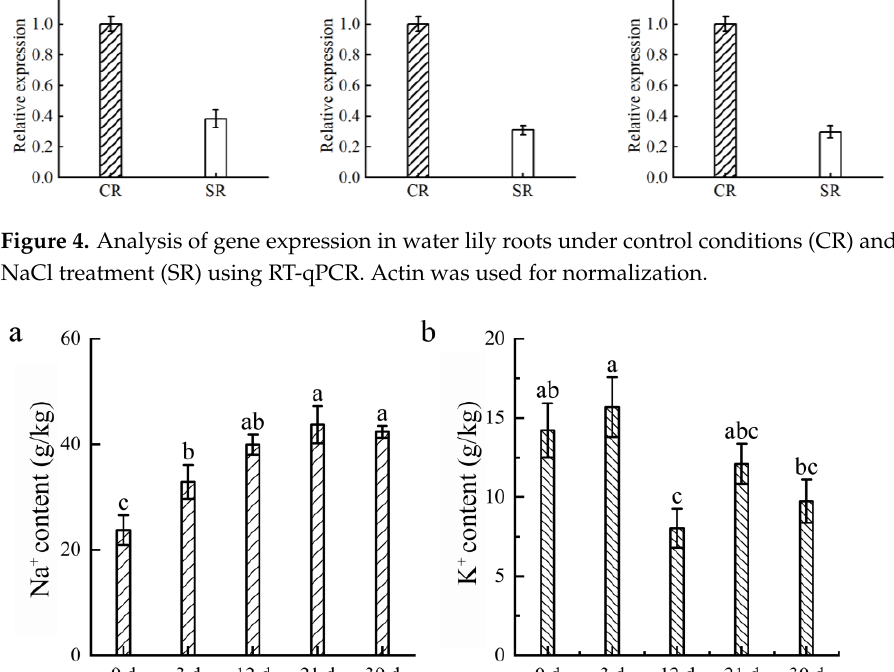
Figure 4. Analysis of gene expression in water lily roots under control conditions (CR) and 150 mM NaCl treatment (SR) using RT-qPCR. Actin was used for normalization.